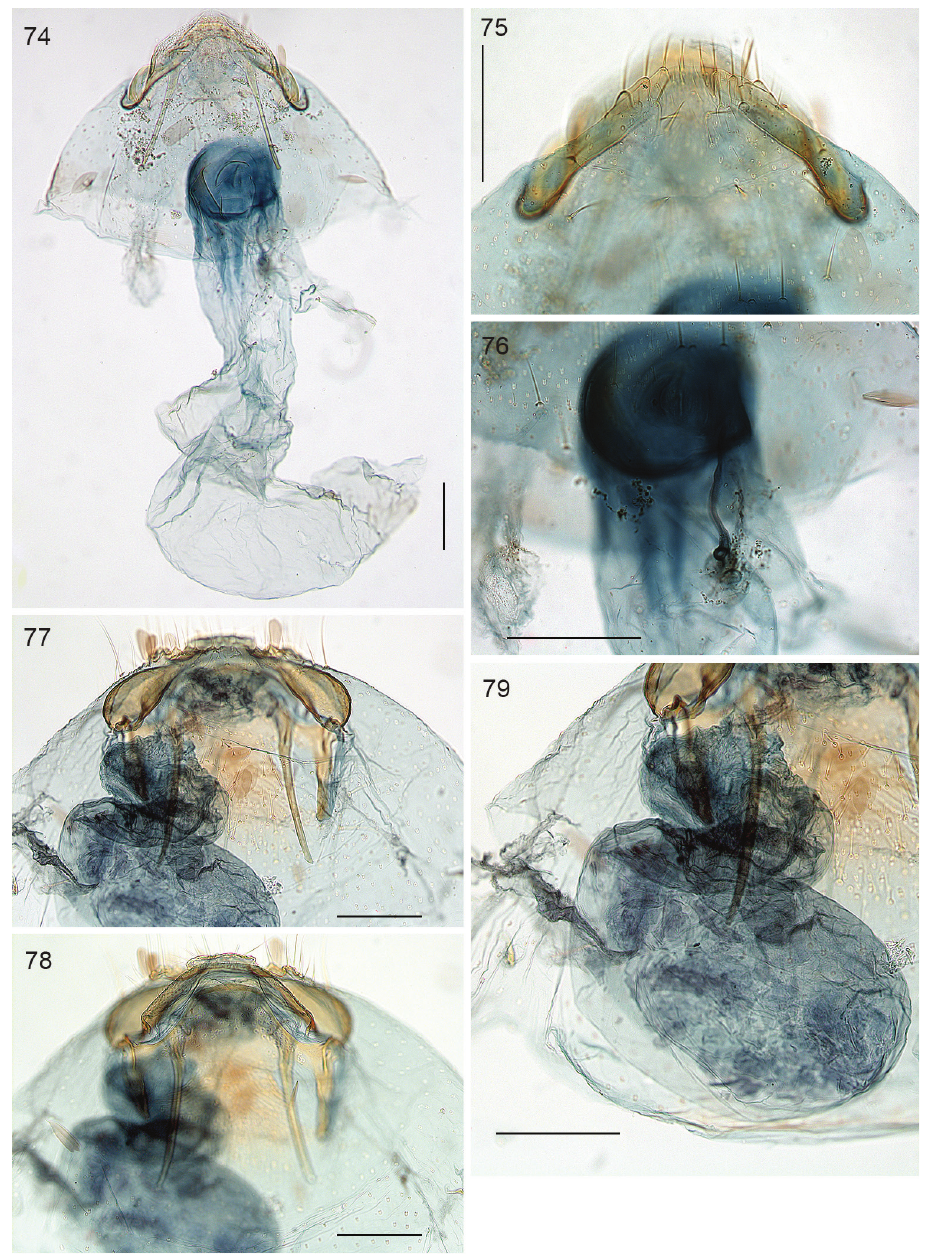
Figures 74–79. Ozadelpha gen. n., female genitalia. 74 O. conostegiae , dorsal view, slide 4847 75 ditto, detail of T8 in dorsal view 76 ditto, detail of ductus spermathecae 77–79 O . specimen EvN4680. Scale bars: 100